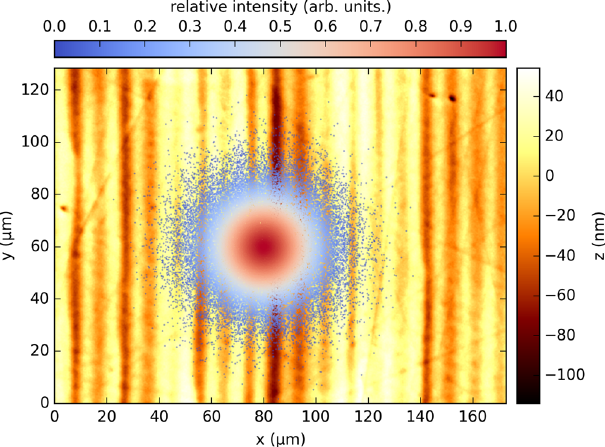
FIG. 10. Simulation configuration. The yellow-black back- ground shows the morphology of the surface we employed in the simulation, while the blue-red spot in the center describes the transverse intensity distribution of the laser.